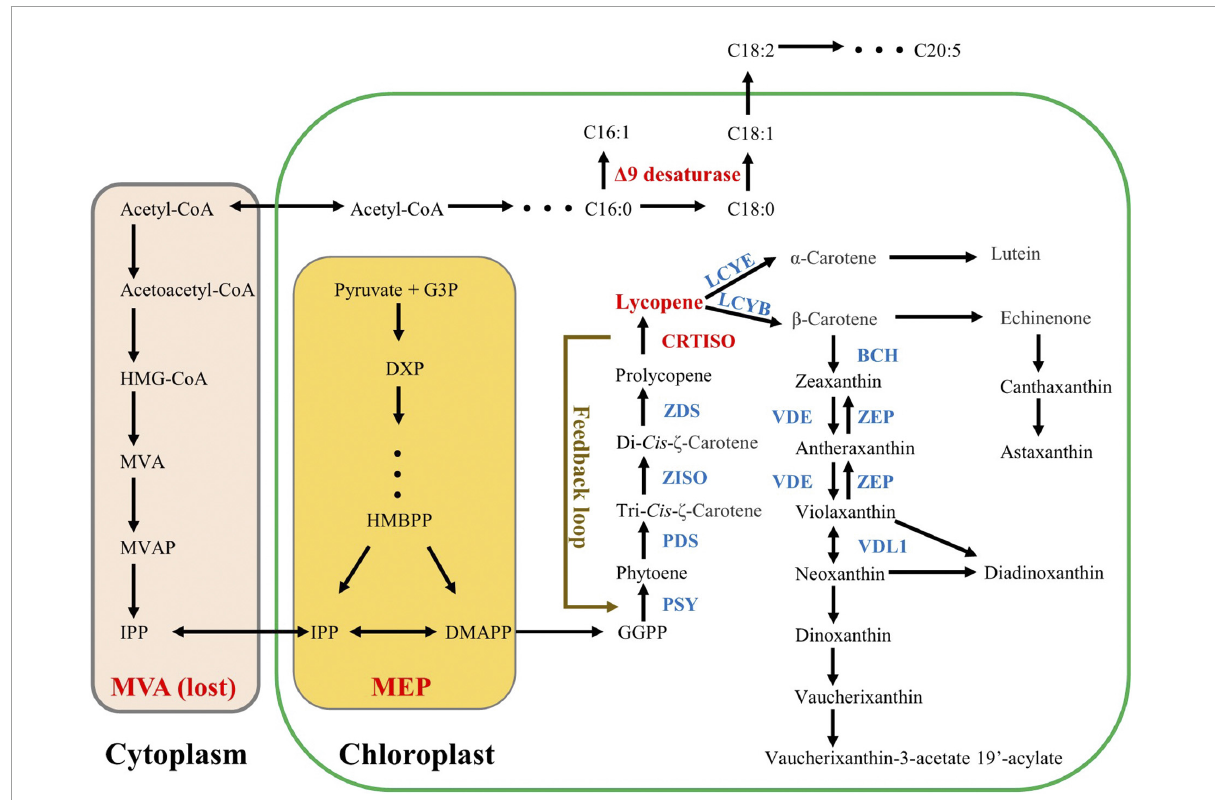
FIGURE1 Hypothetic carotenoid pathway in Nannochloropsis . Lycopene is the first branch point in carotenoid biosynthesis pathway. Acetyl-CoA is the common precursor for both MVA pathway and fatty acid pathway, and Nannochloropsis had lost the former one. Both C16:1 and C18:1 are catalyzed by (cid:49) 9 desaturase. The presence of a feedback loop between CRTISO and PSY is proposed by our